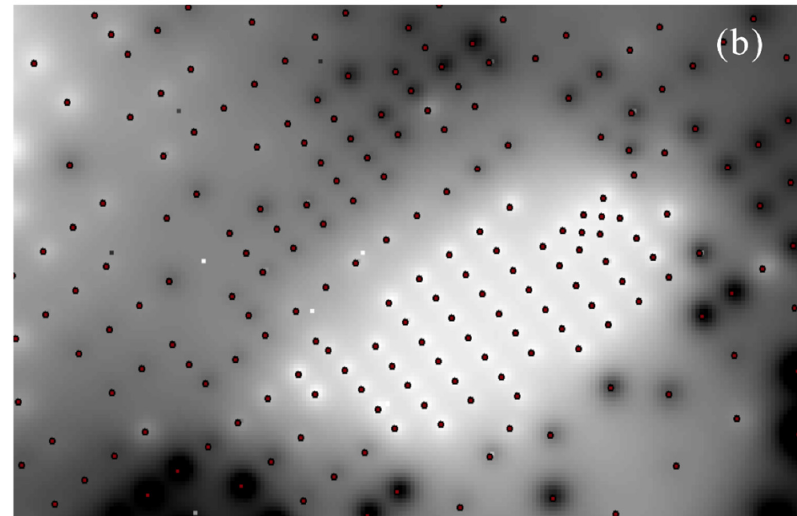
Figure 4. ( a ) A comparison of anomalies delineated using the singularity method ( a ) and the traditional statistical method ( b ). The dot in the figure indicates the position of the sampling point, and the black area is the determined abnormal area.